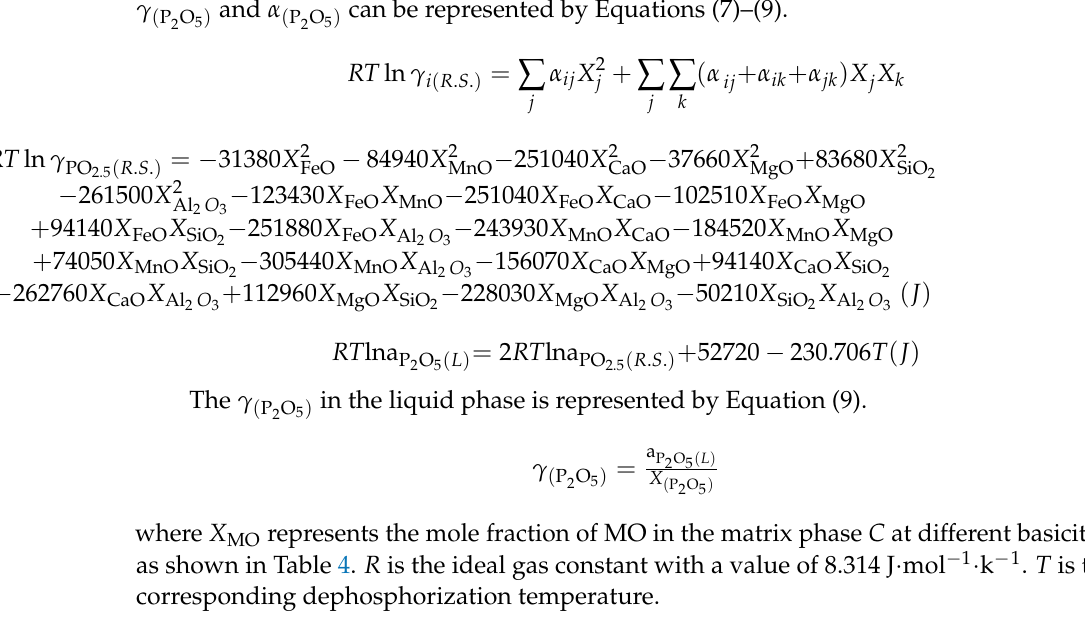
Table 6. Interaction energy between cations of major components in steelmaking slag, α ij . (J).